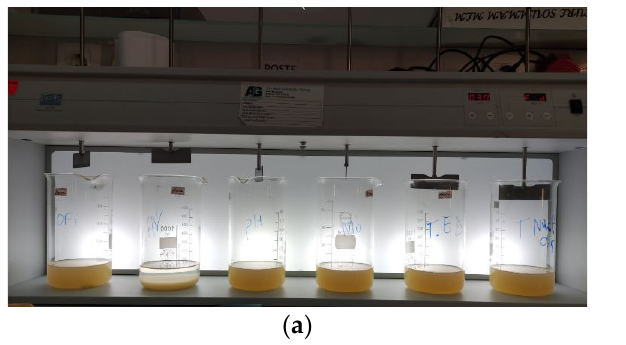
Figure 1. ( a ): Jar test apparatus used in this study; ( b ): treated water.